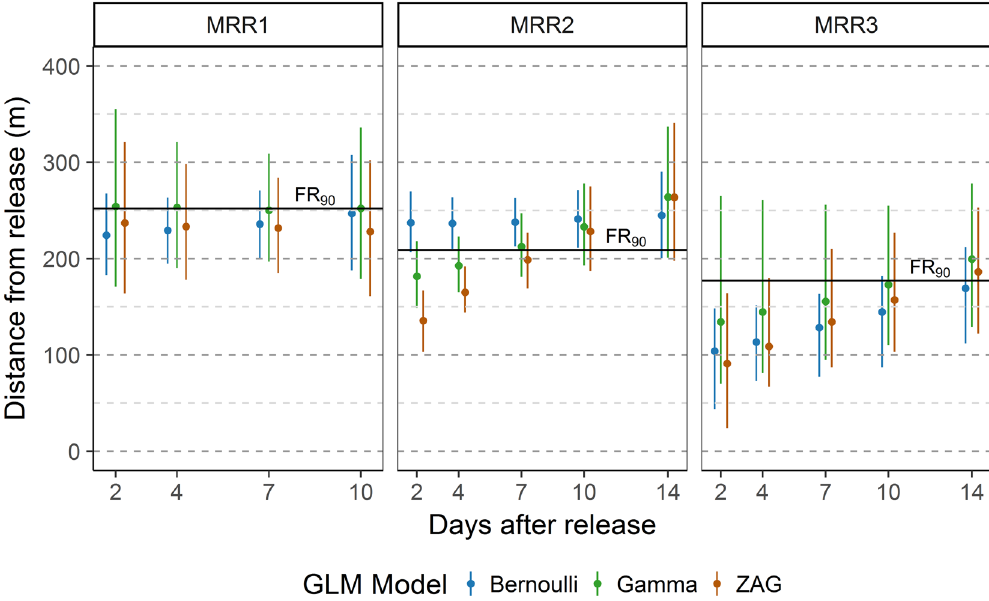
Figure 3. Distance up to which 90% of mosquitoes are expected to travel estimated by three models (Bernoulli GLM, Gamma GLM, Zero Altered Gamma model). On the x-axis the days after release, on the y-axis the distance from the release site. Dots represent the mean distance value; vertical lines represent the 95% confidence intervals obtained by non-parametric bootstrap. The horizontal solid black lines represent the flight ranges of 90% marked Aedes albopictus (FR 90 , calculated according to Lillie et al . 29 , White & Morris 30 ,